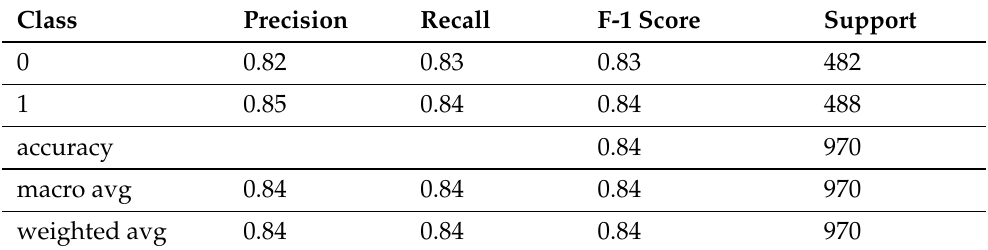
Table 10. Classification report for TF-IDF with LSTM.